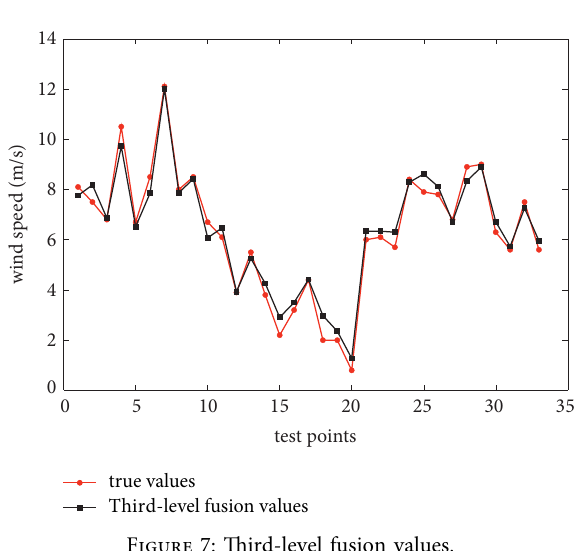
Figure 6: Second-level fusion values.